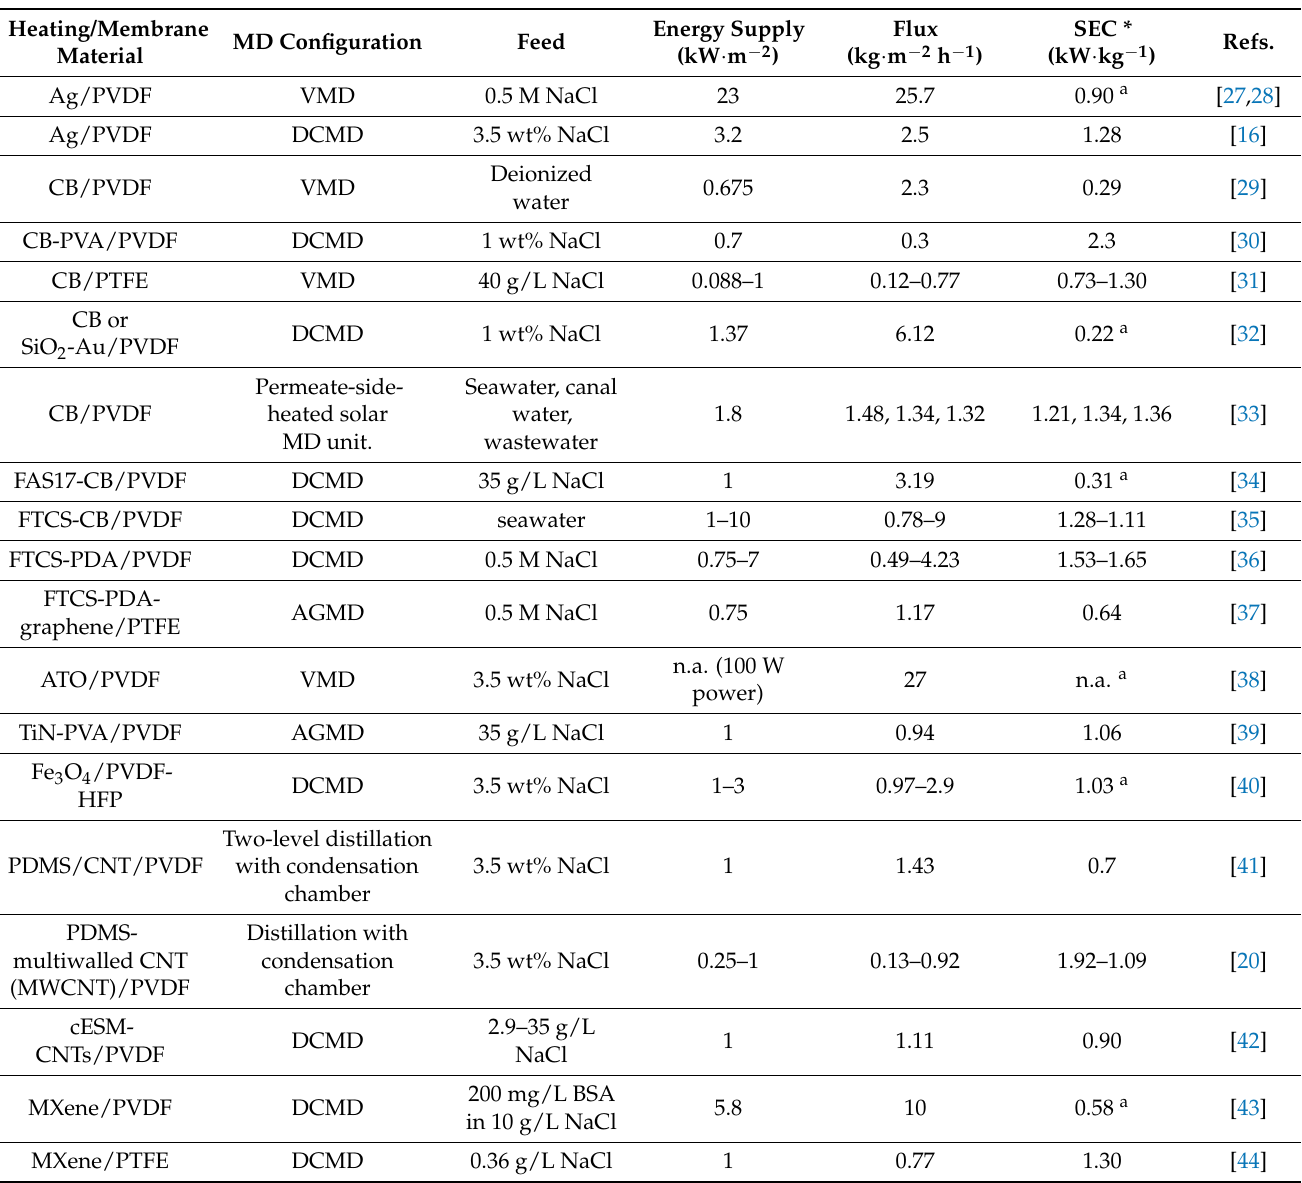
Table 2. Irradiation heating on modified membranes (best